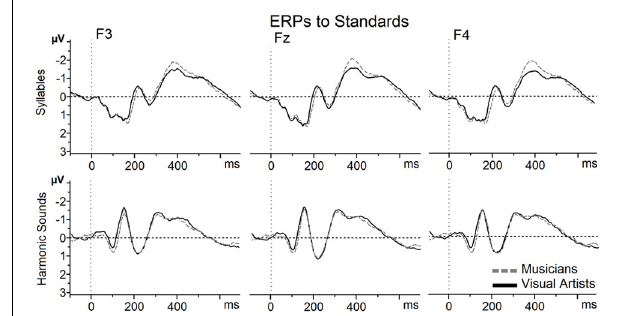
FIGURE 2 | ERPs to standards, Mandarin syllable and harmonic sounds, recorded at Frontal sites (F3, Fz, and F4) are overlapped for musicians (gray dashed line) and visual artists (black solid line). On this and subsequent figures, time in milliseconds is in abscissa and the amplitude of the effects in microvolts is in ordinate. Time zero corresponds to sound onset and negativity is up.